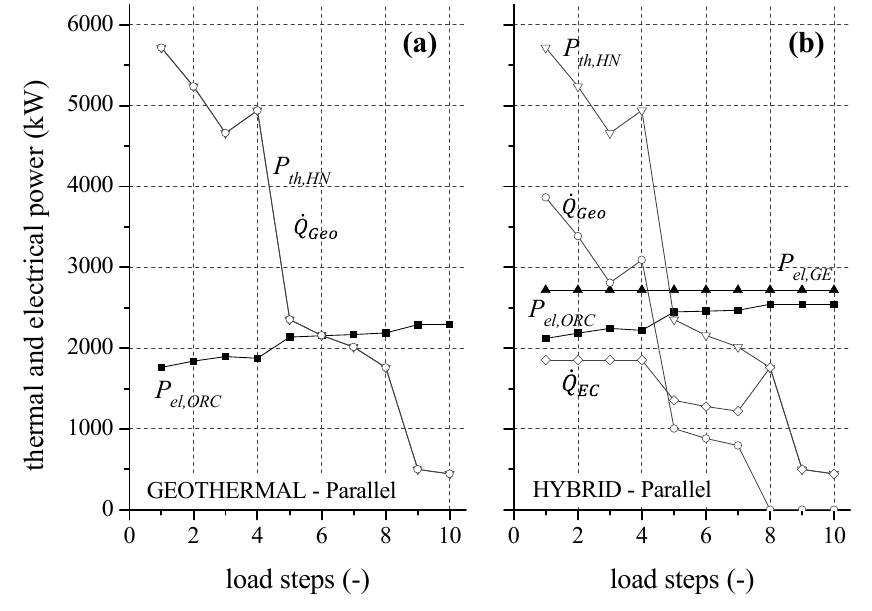
Figure 5. Electrical and thermal power of the power plant units ( a ) Geothermal CHP in parallel circuit; ( b ) Hybrid power plant in parallel circuit.